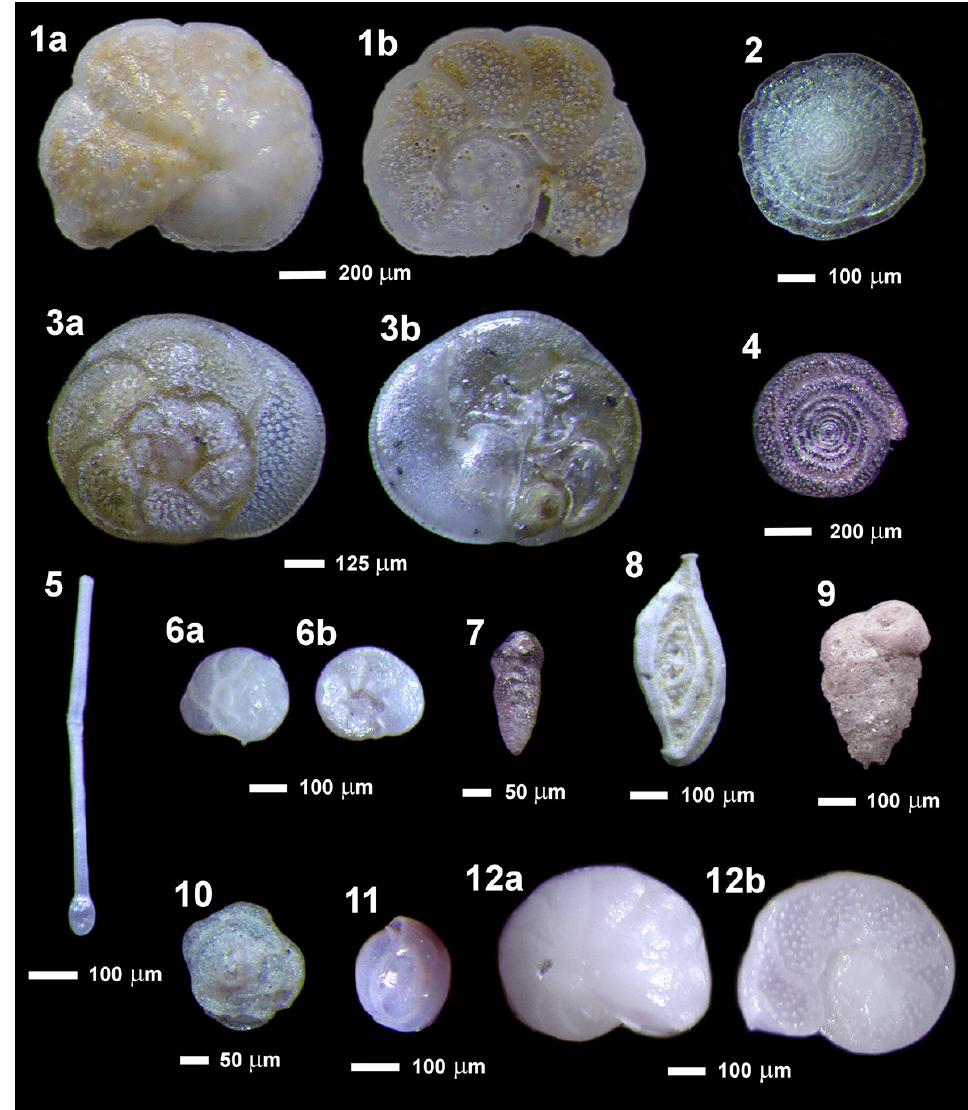
Figure 6. Commonly occurring Benthic Foraminifera in the CT12 cave: ( 1 ) Cibicidoides lobatulus , ventral view (a), dorsal view (b); ( 2 ) Patellina corrugata , dorsal view; ( 3 ) Rosalina bradyi , dorsal view (a), ventral view (b); ( 4 ) Spirillina vivipara ; ( 5 ) Tubinella inornata , lateral view; ( 6 ) Gavelinopsis praegeri , dorsal view (a), ventral view (b); ( 7 ) Bolivina variabilis , lateral view; ( 8 ) Spirophthalmidium emaciatum , lateral view; ( 9 ) Textularia bocki , lateral view; ( 10 ) Sejunctella sp., dorsal view; ( 11 ) Miliolinella subrotunda , lateral view; ( 12 ) Cibicides refulgens , ventral view (a), dorsal view (b) [114].